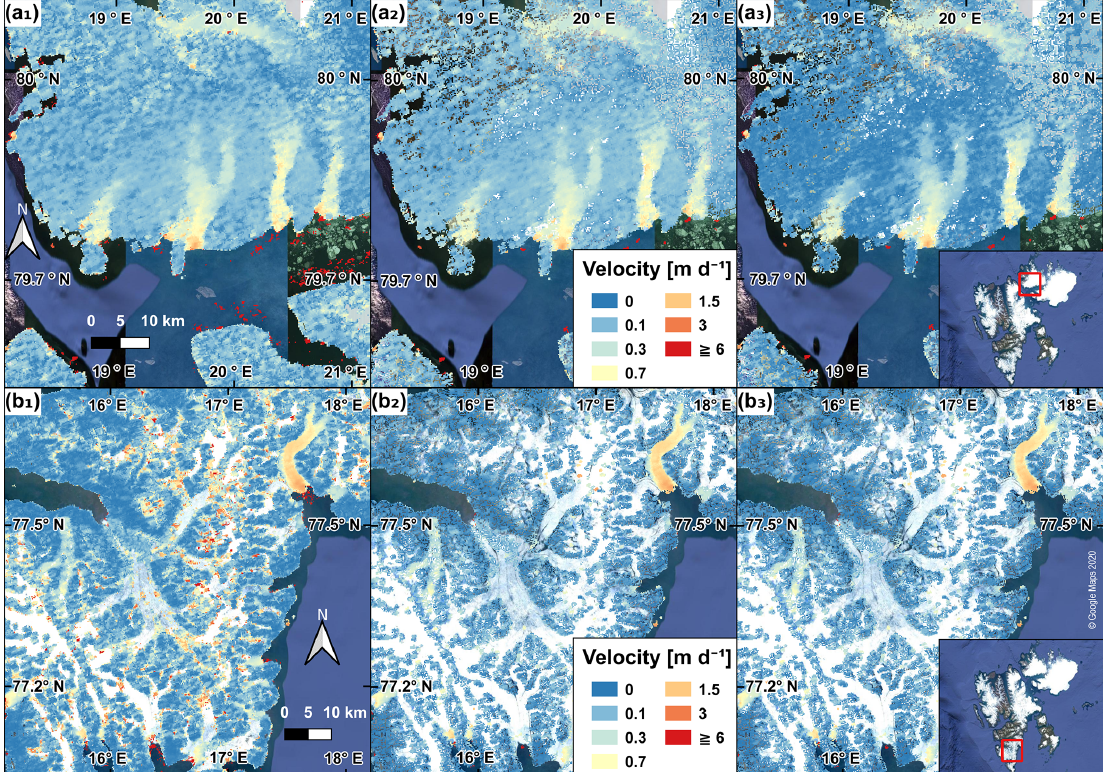
Figure 3. Examples of raw, filtered and corrected single velocity fields. Raw velocity (magnitude) fields from 15 January 2019 (6d repeat pair, a1 ) and 11 August 2019 (12d repeat pair, b1 ). Filtered products using the approach of Lüttig et al. (2017) are shown in panels (a2) and (b2) . The products that were corrected for coregistration errors are displayed in panels (a3) and (b3) . The short 6d temporal baseline of the 15 January 2019 velocity field and the absence of surface melt during winter allowed for tracking radar speckle on the almost featureless surface of Vestfonna ice cap. Filtering effectively removed existing blunders while keeping reliable measurements in both examples. While coregistration error correction significantly improved the velocity field on Vestfonna (a3) , it had only minor effects on the velocities from 11 August 2019 (b3) due to abundant ice-free area in this scene. The coregistration error correction values applied to both velocity fields are shown in Fig. 4. Background: © Google Maps